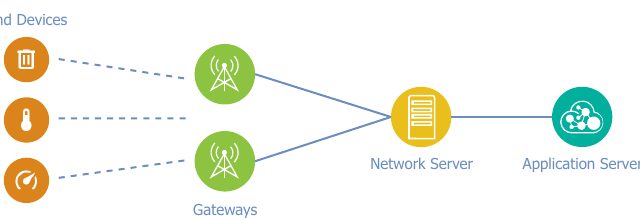
Figure 2. Standard LoRaWAN